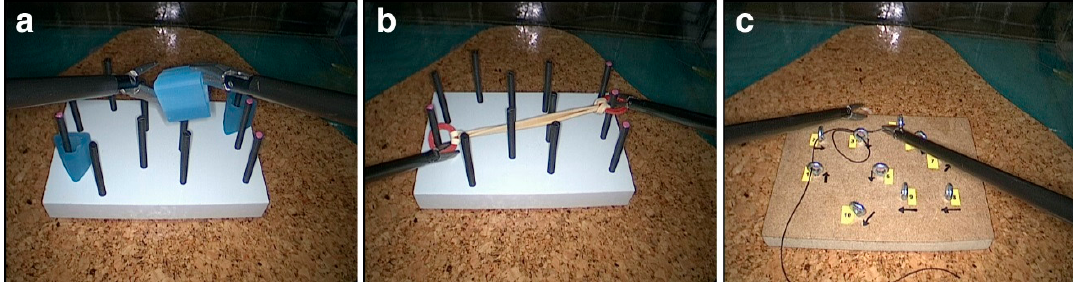
Figure 3. Tasks: ( a ) Hand-eye coordination, ( b ) coordinated traction and ( c ) transfer task (labyrinth).